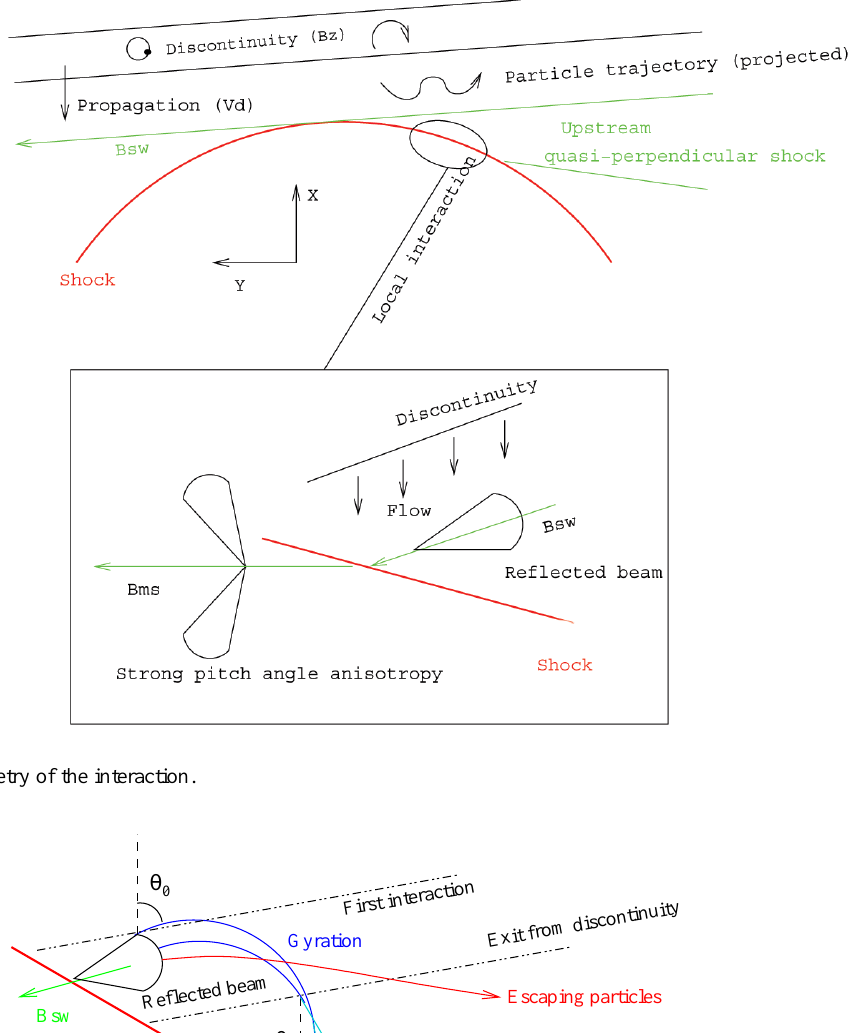
Fig. 7. General geometry of the interaction.